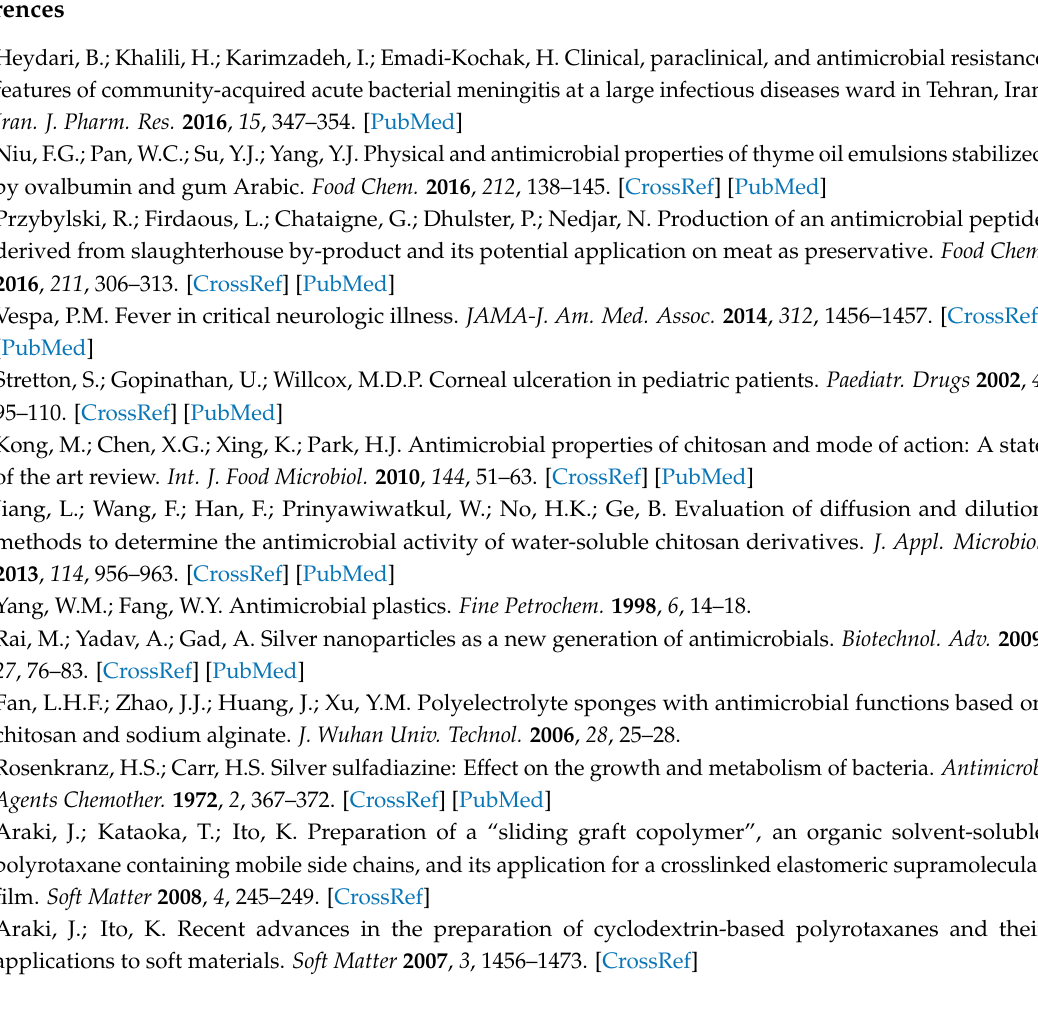
Figure S1: The FTIR spectra of PR, SD-Ag, PR+SD-Ag and PR-(SD-Ag), Figure S2: The XRD patterns of PR-(SD-Ag), SD-Ag and PR, Table S1: Antibacterial rate of PR 1 t -(SD-Ag) and PR 2 t -(SD-Ag) on E. coli and S. aureus